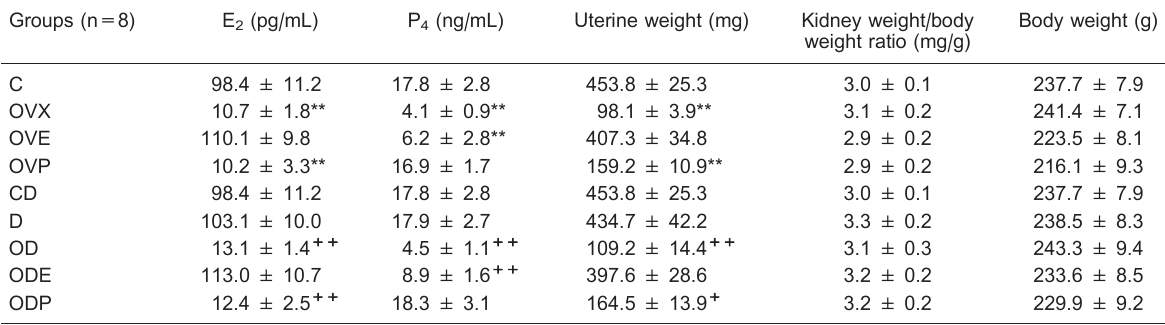
Table 1. Changes in E 2 and P 4 plasma levels, and uterine, kidney, and body weight in female rats. Groups